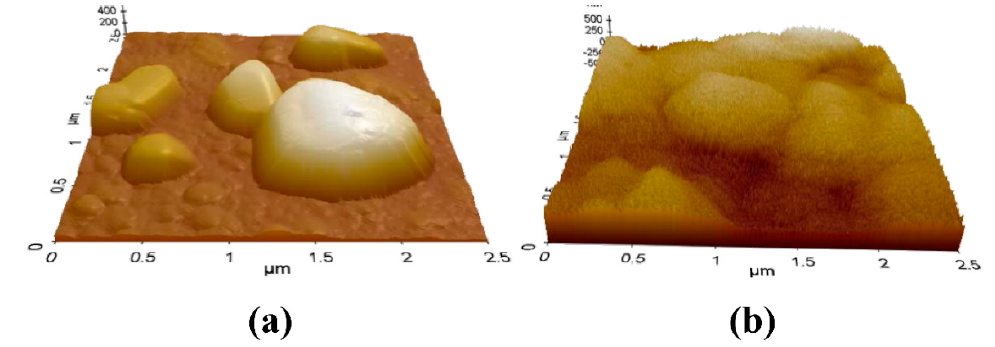
Figure 4. Three-dimensional atomic force microscopic (AFM) topography of ( a ) Ag-hc@Si and ( b )